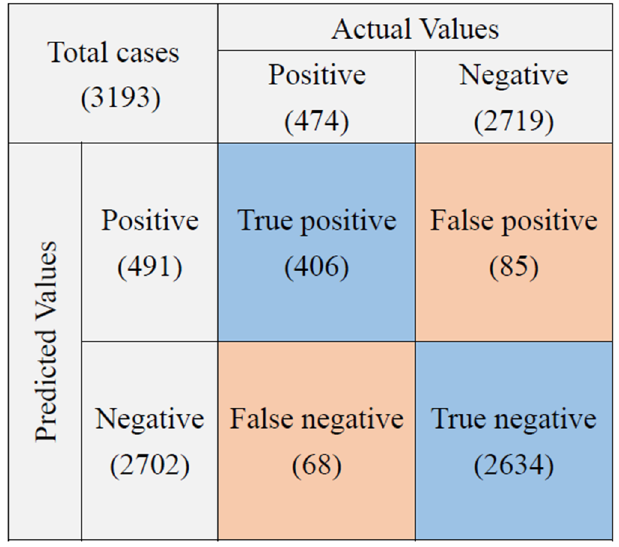
Figure 5. The confusion matrix of automation system with 200 images capture setting.